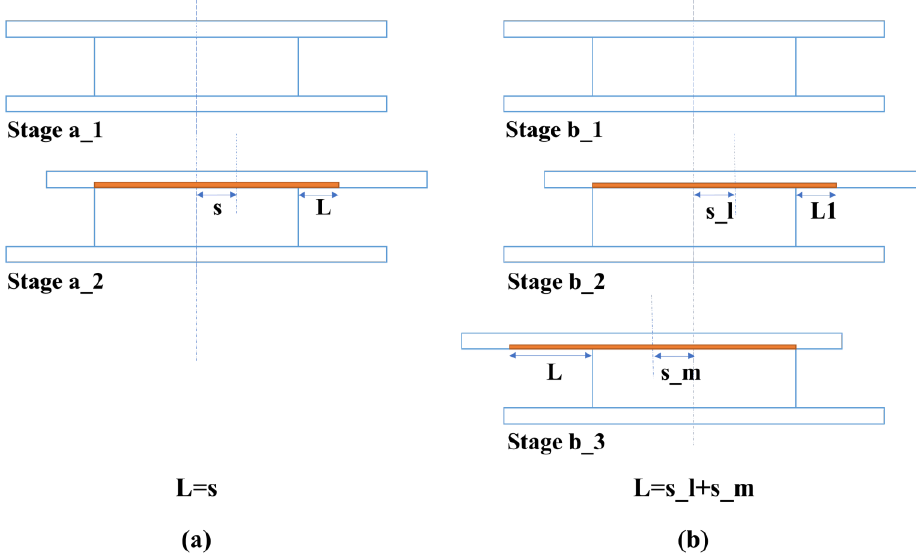
Figure 7. Support slip mark on top plate: ( a ) situation that centerline of the top plate is on one side of the support centerline during slip; ( b ) situation that centerline of the top plate crosses from one side of the support centerline to the other during slip.